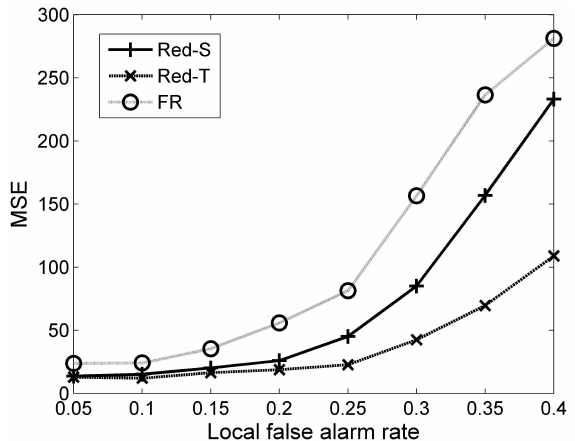
Figure 7. Mean squared error (MSE) of Red-S, Red-T, and FR vs. the false alarm probability of local nodes in a 500-node network. P 0 = 1000 has been considered in